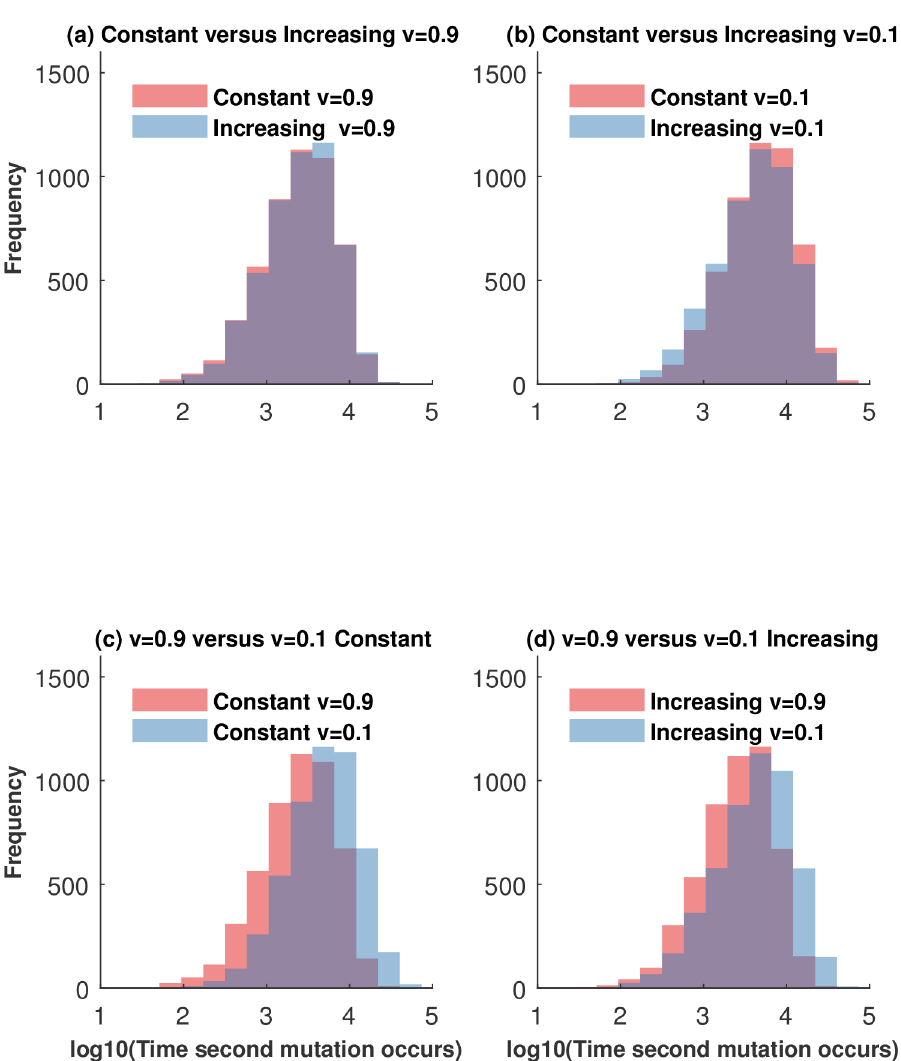
increasing from C 0 to C 3 ( N 0 = 20, N 1 = 40, N 2 = 80, N 3 = 120). (a) The time to observe a second mutant for both architectures and a high value of the self-renewal probability, v = 0.9. The mean time for constant and increasing architectures is 3.33 and 3.39 respectively; the p -value obtained by two-tailed t -test is p = 0.078, indicating that the means are different only at the 10% level (size effect is 0.04). (b) The time to observe a second mutant for both architectures and a small value of the self-renewal probability, v = 0.1. The mean time for constant and increasing architectures is 3.67 and 3.60 respectively; the p -value is p (cid:28) 0.001, indicating that the means are different; the effect size is 0.16. (c) and (d) The time to observe a second mutant for a constant and increasing architecture, respectively, for small and high v . In these simulations u = 0.001, and the effect size is 0.68 and 0.46